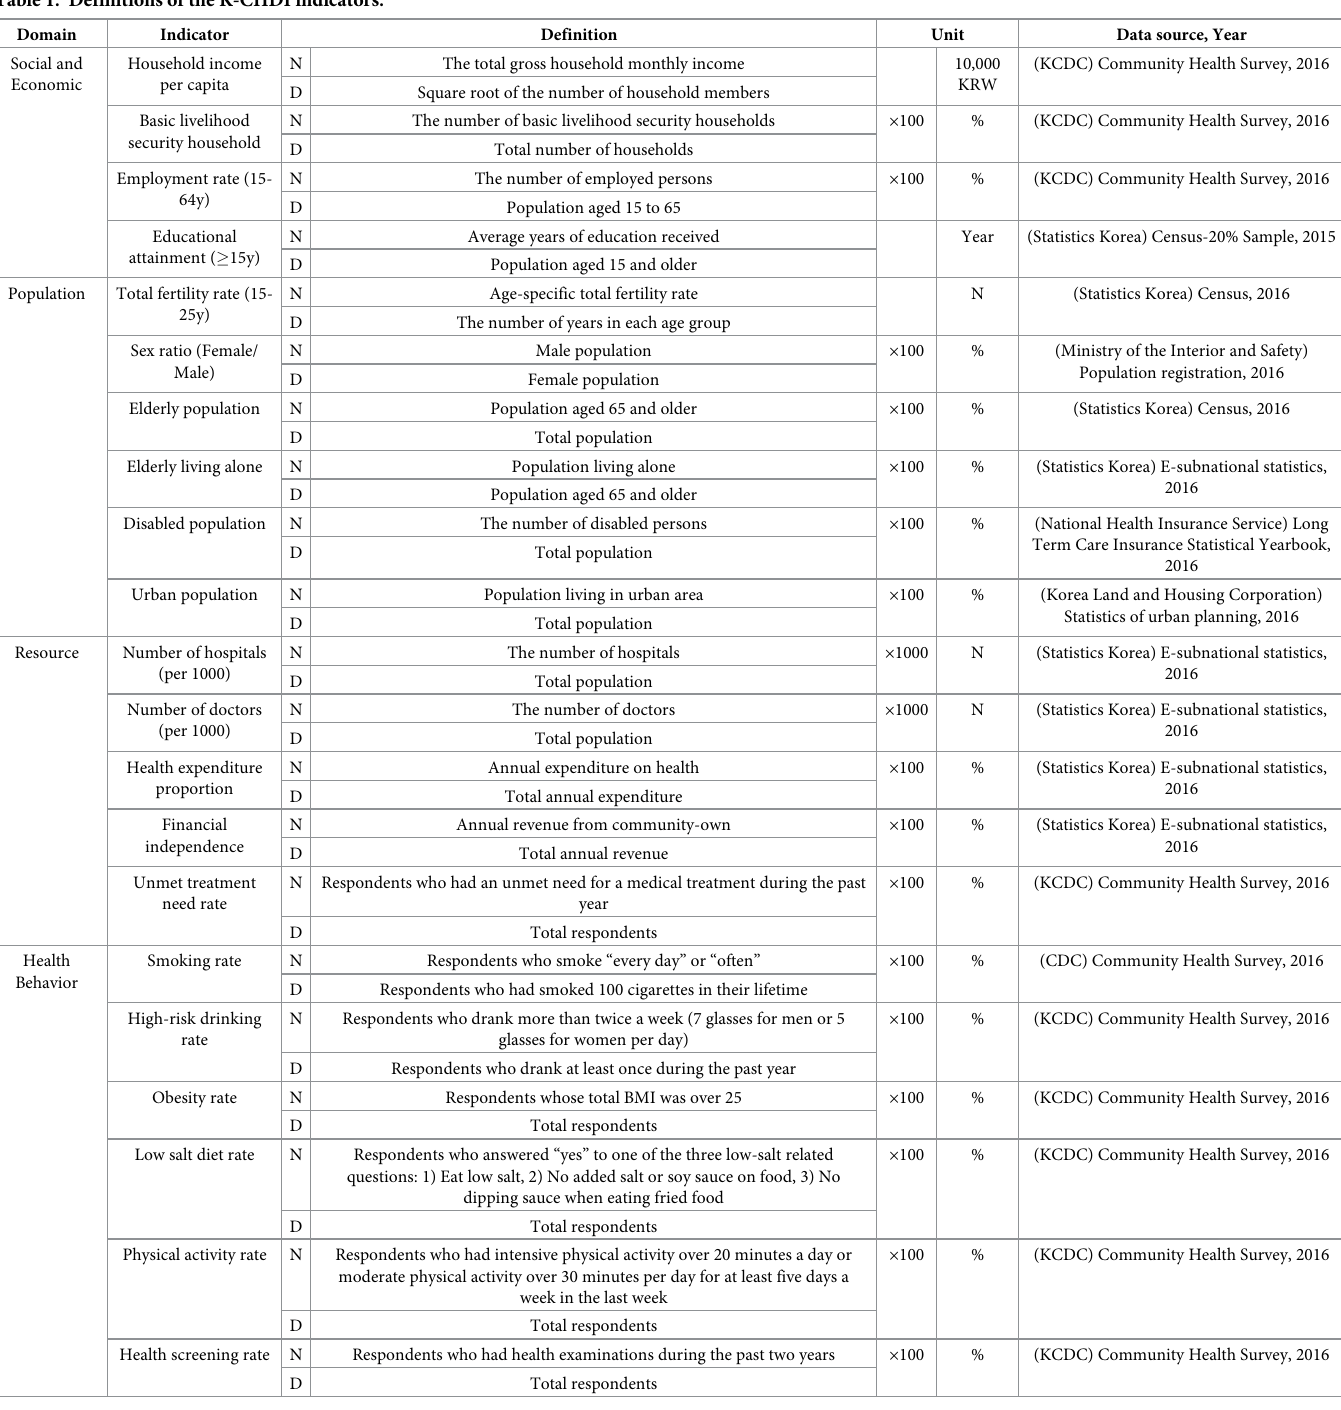
Table 1. Definitions of the K-CHDI